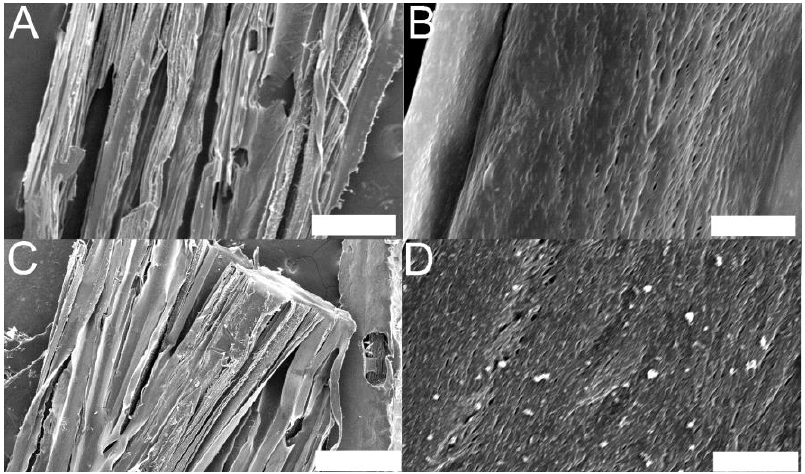
Figure 4. Scanning electron microscope images of sections of PCL-based tissue scaffolds with aligned pores. ( A ) Millimeter and micrometer scale topography of non-electroactive scaffolds, scale bar represents 500 µm. ( B ) Micrometer and nanometer scale topography of non-electroactive scaffolds, scale bar represents 10 µm. ( C ) Millimeter and micrometer scale topography of electroactive scaffolds, scale bar represents 500 µm. ( D ) Micrometer and nanometer scale topography of electroactive scaffolds showing evidence of increased nanometer scale surface roughness due to the presence of an interpenetrating network of PPy and PSS interwoven within the PCL matrix, scale bar represents 10